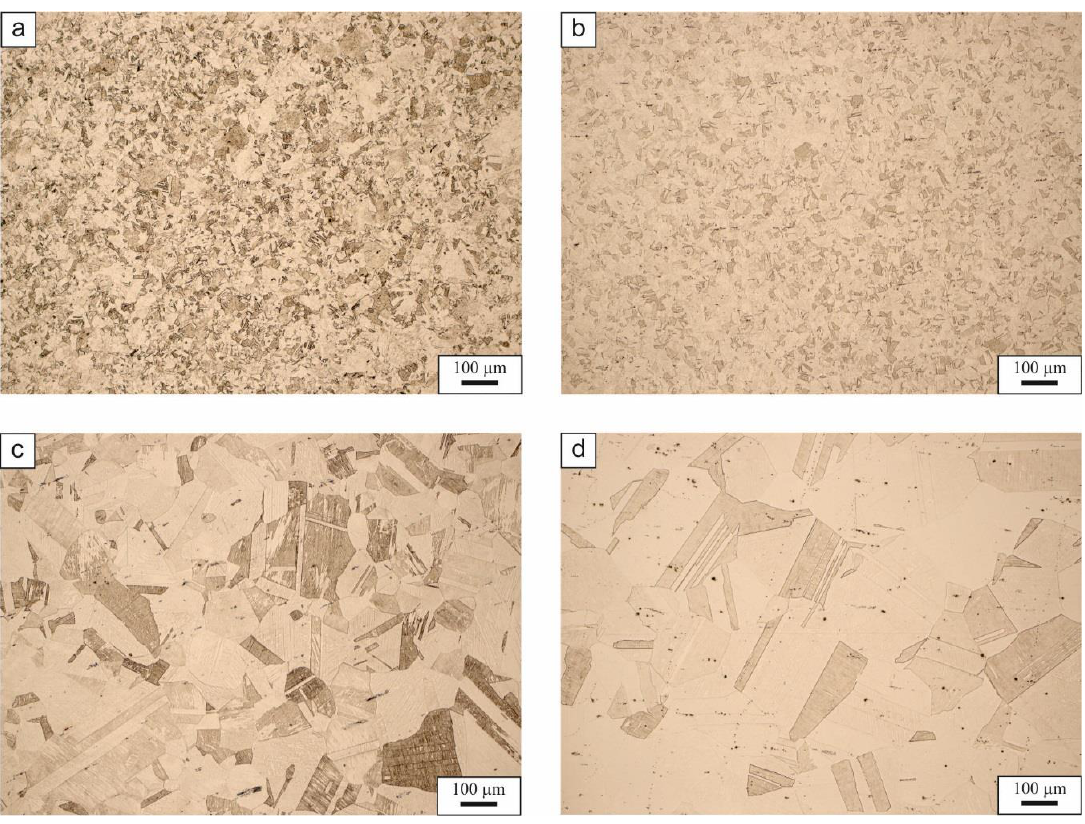
Figure 1. Austenitic microstructures of investigated steel after the solution heat treatment at the temperature of 900 ( a ), 1000 ( b ), 1100 ( c ) and 1200 ◦ C ( d ). temperature of 900 ( a ), 1000 ( b ), 1100 ( c ) and 1200 °C ( d ).